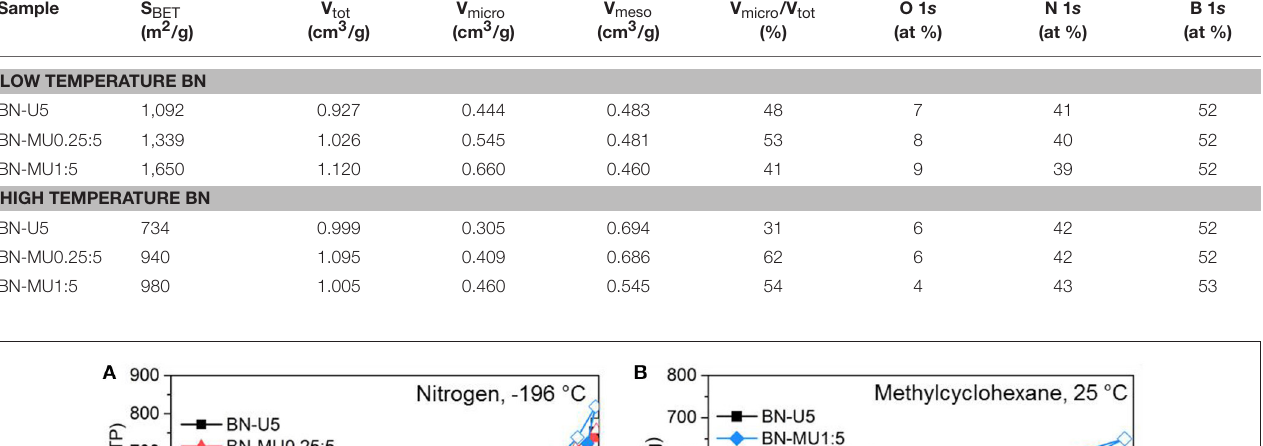
TABLE 1 | Overview of the porosity and chemistry of the porous BN samples: textural parameters derived from nitrogen sorption isotherms at − 196 ◦ C and relative atomic percentages derived from XPS analysis. Sample